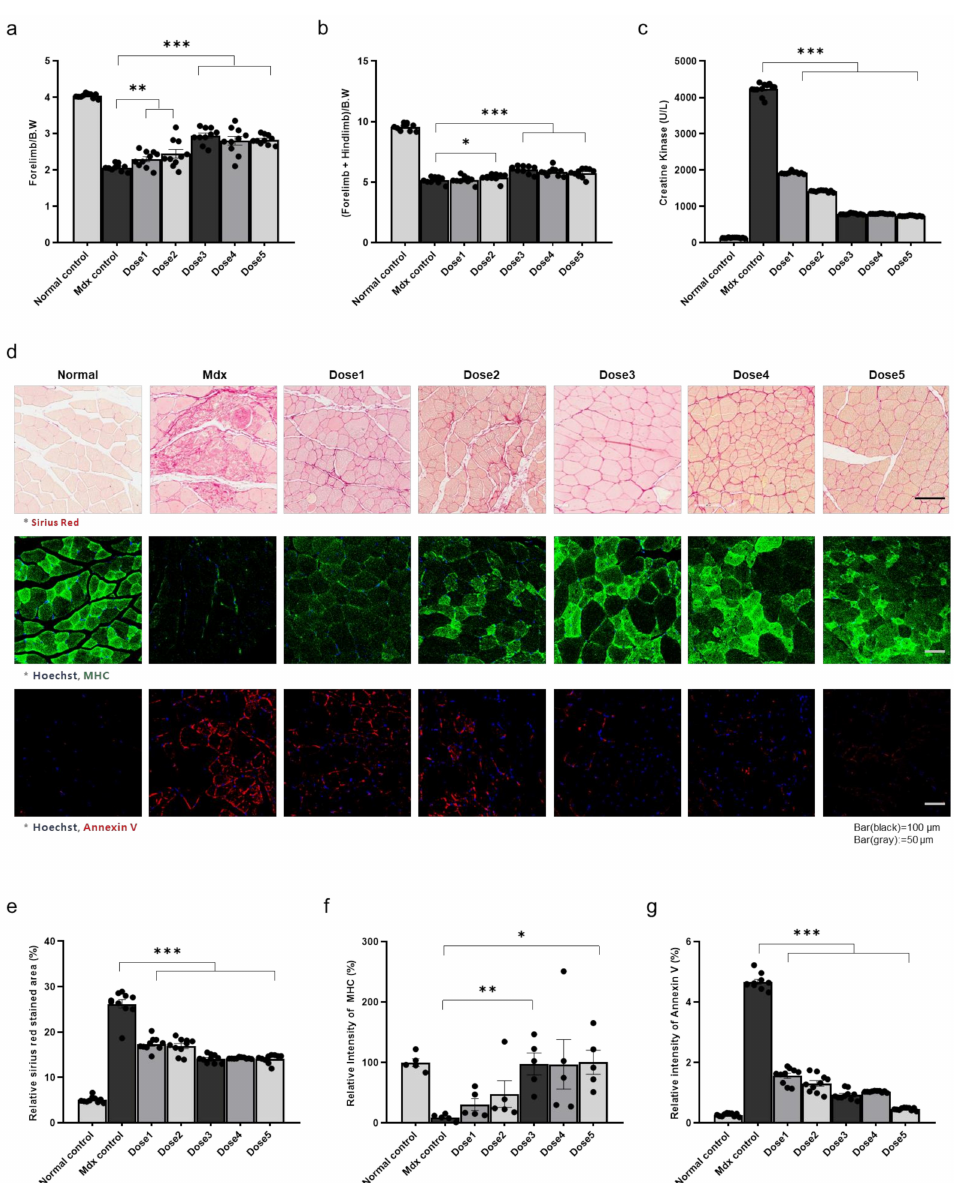
Figure 1. Therapeutic effects of Wharton’s jelly-derived mesenchymal stem cells (WJ-MSCs) in the skeletal muscle of mdx mice ( a ) Forelimb grip strength, ( b ) forelimb + hindlimb grip strength, ( c ) creatine kinase (CK) levels, ( d ) fibrotic areas, and myosin heavy chain and annexin V expression levels were measured in control, untreated mdx mice, and WJ-MSC-treated mdx mice. ( e – g ) Quanti- tative measurements were performed in ImageJ. The data are expressed as the mean ± SEM. Bars with different superscripts indicate significantly different values (* p < 0.05, ** p < 0.01, *** p <